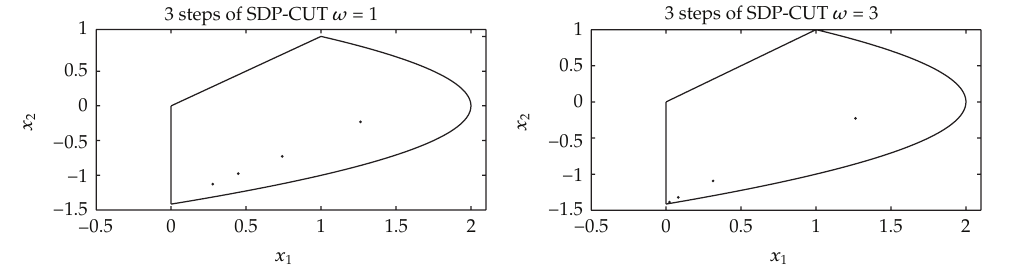
Figure 14: Convergence of SDP-CUT for w (cid:7) 1 and w (cid:7) 5.